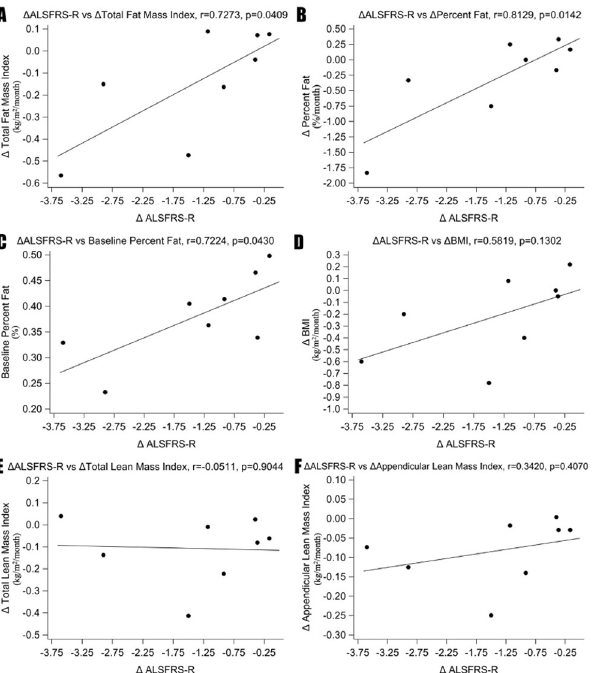
Fig 3. Correlation between Δ ALSFRS-R with baseline and longitudinal DEXA measurements. Δ ALSFRS-R correlates significantly with (A) Δ Total Fat Mass Index, (B) Δ Percent Fat and (C) baseline percent fat. The correlation is not significant with (D) Δ BMI, (E) Δ Total Lean Mass Index and (F) Δ Appendicular Lean Mass Index.